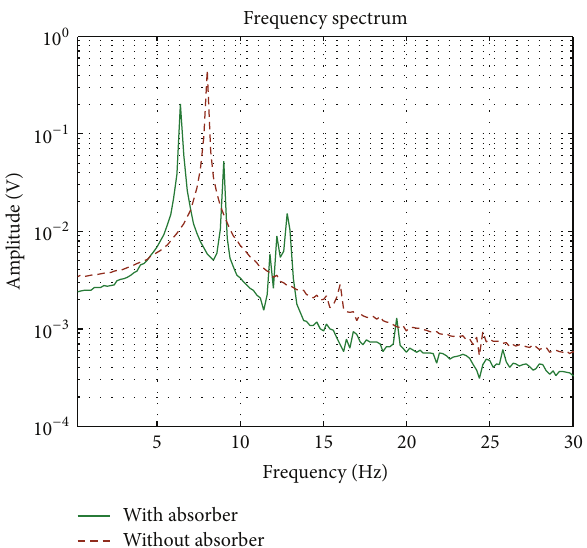
Figure 9: Frequency spectrum of the response with and without absorber in a broader range of frequencies for comparison.